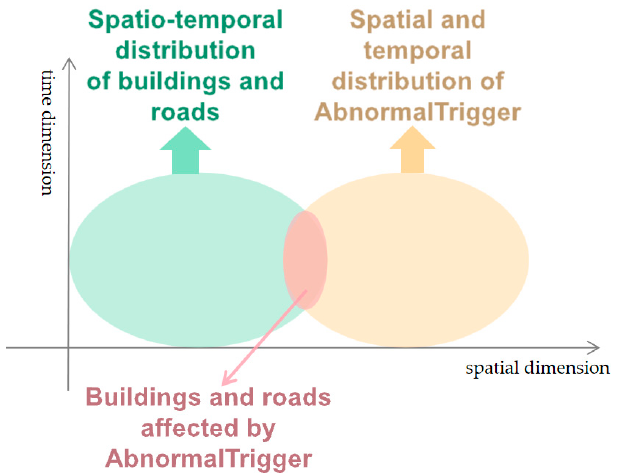
Figure 10. Schematic diagram of the spatio-temporal intersection of anomalous events and geo- graphic entities.